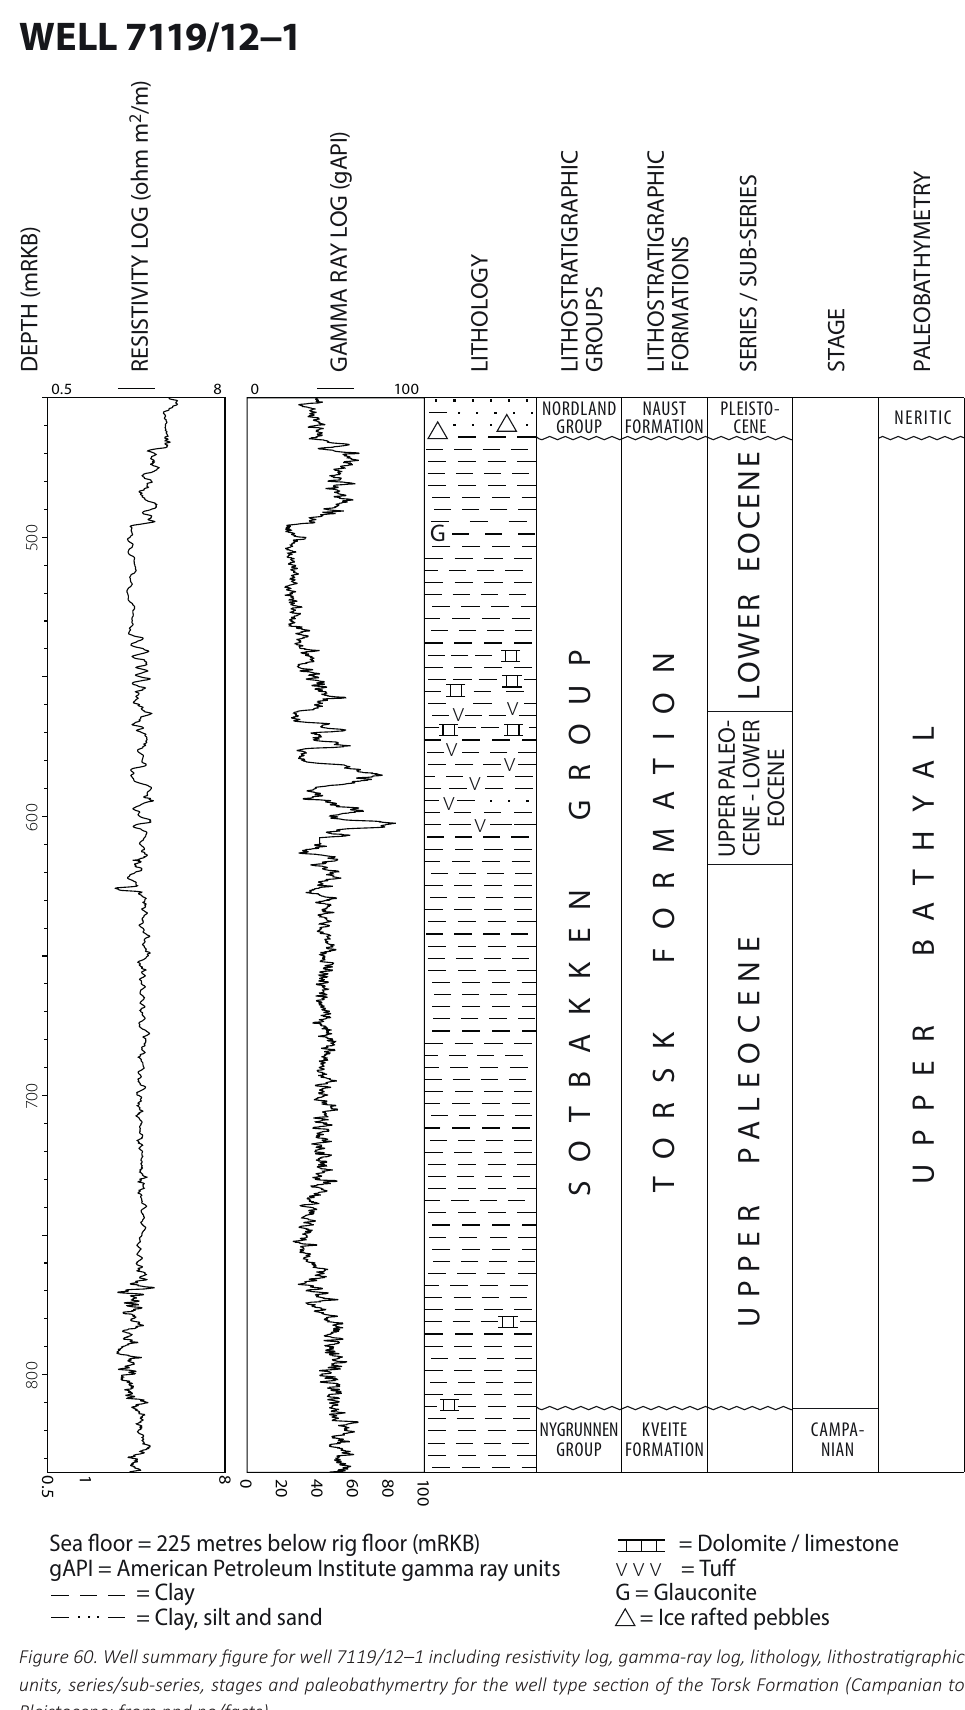
Figure 60. Well summary figure for well 7119/12–1 including resistivity log, gamma-ray log, lithology, lithostratigraphic units, series/sub-series, stages and paleobathymertry for the well type section of the Torsk Formation (Campanian to Fig. 60 Pleistocene; from